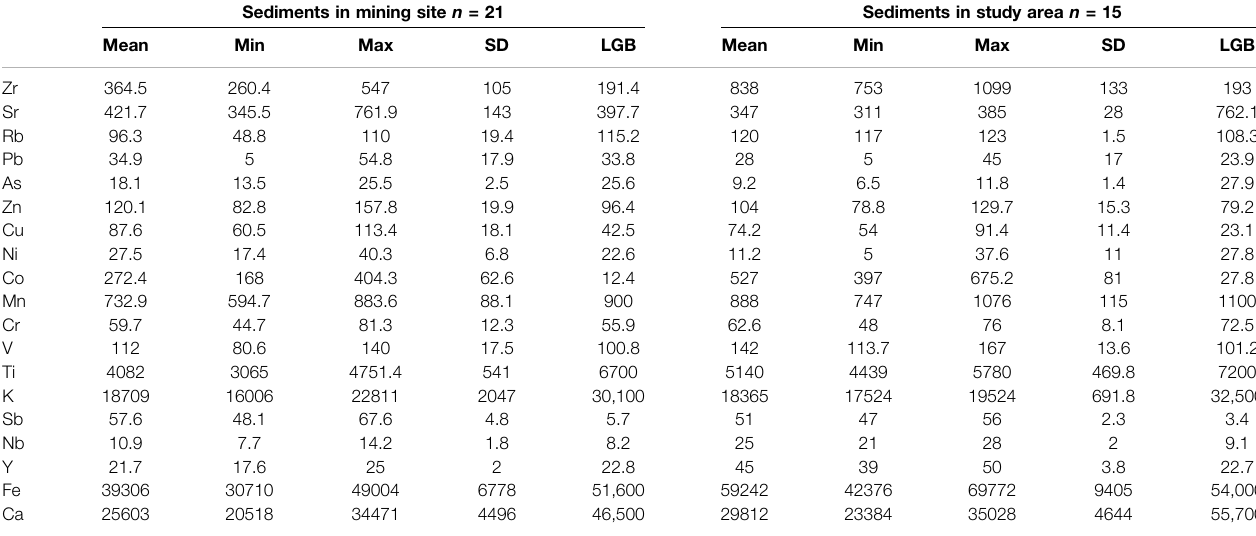
TABLE 1 | Geochemistry of riverbank sediments collected from 1) active mining area of Bacanuchi and 2) study area where amphibian and mites were collected. Sediments in mining site n =